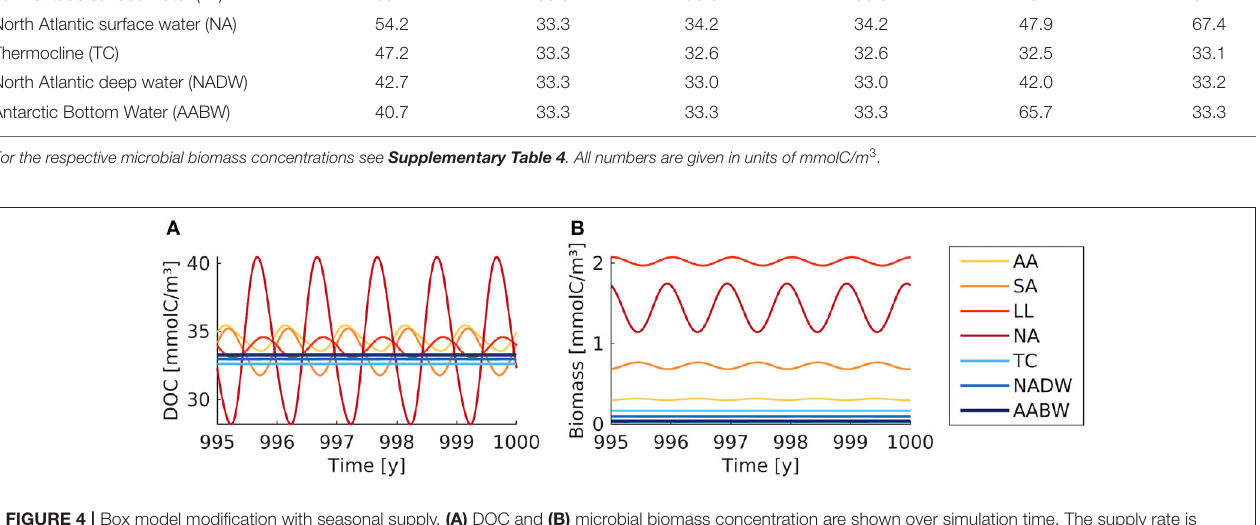
FIGURE 4 | Box model modification with seasonal supply. (A) DOC and (B) microbial biomass concentration are shown over simulation time. The supply rate is interpolated between monthly average values. The colored lines indicate the concentrations in the seven boxes (AA, Antarctic surface water; SA,